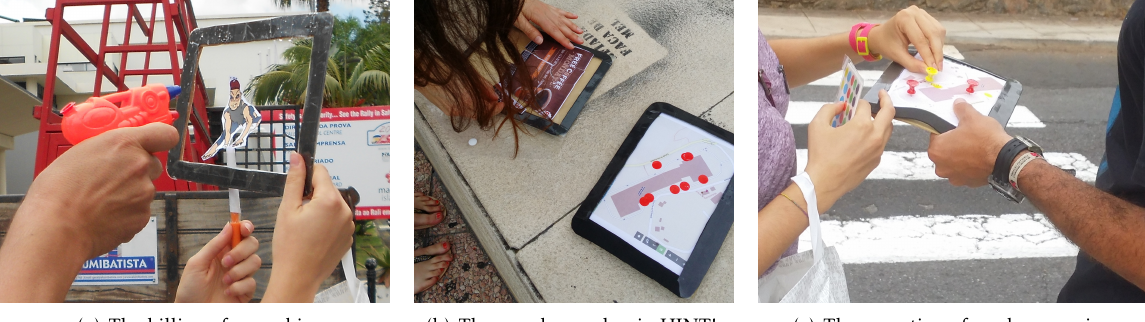
Figure 2. Pictures related to the experience